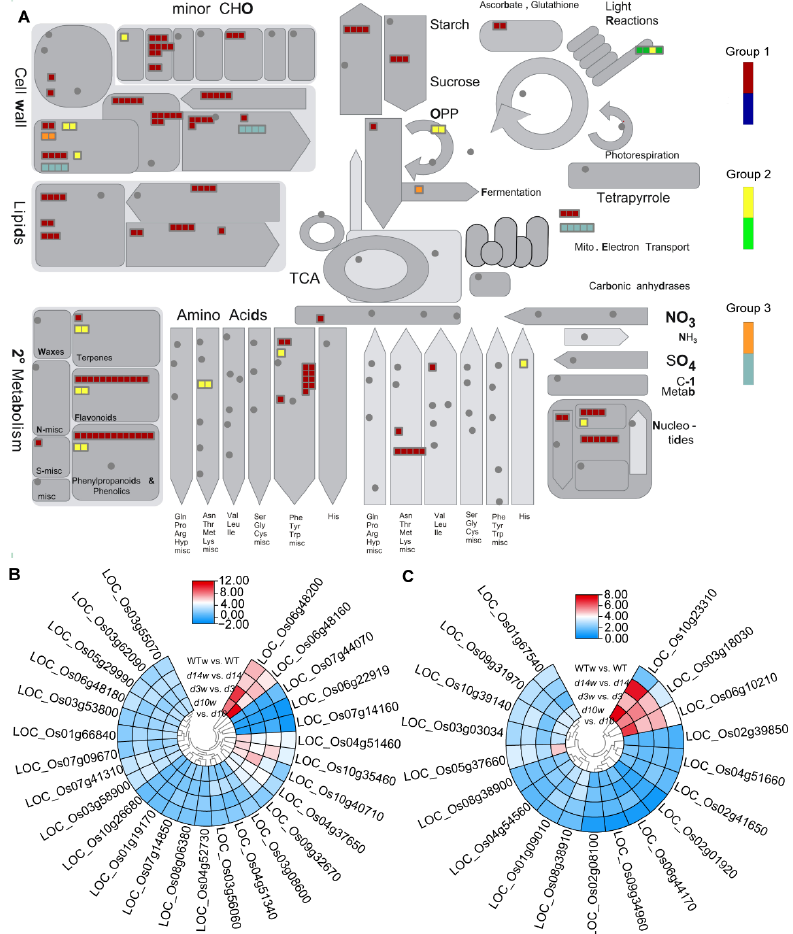
Figure 6. MapMan analysis based “metabolic overview map” of DEGs in three groups. ( A ) Schematic diagram of metabolic overview categories. The small heatmap in each section of the diagram shows the DEGs mapped to the pathway and a small square indicates a transcript. Red, orange, and yellow indicate upregulated genes in each group; blue, light sea green, and green mean downregulated genes in each group. ( B , C ) DEGs related to ( B ) cell wall and ( C ) secondary metabolism. Heatmaps of DEGs were drawn using the log 2 (FC) value obtained from the pairwise comparison of samples. Red and blue indicate upregulation and downregulation, respectively.